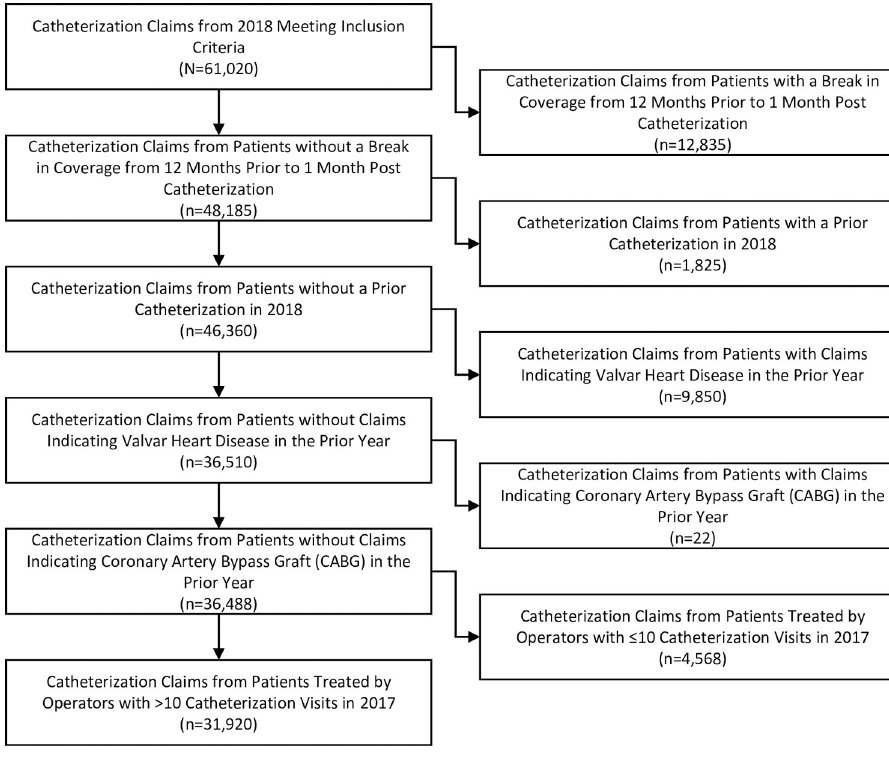
Fig 1. Sample selection